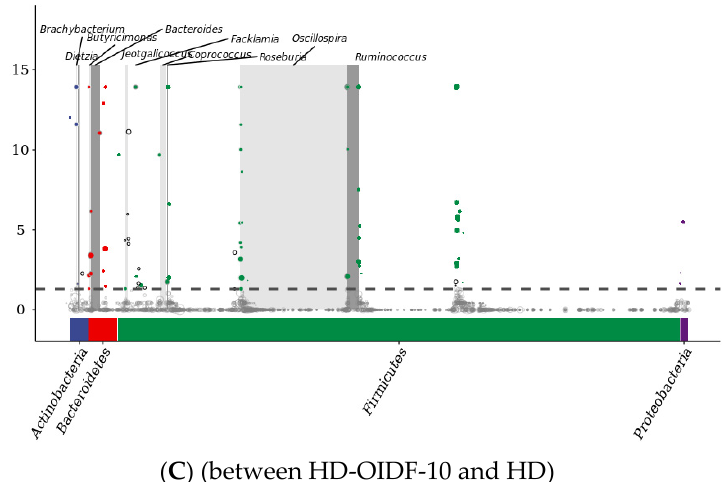
Figure 8. Species differences and marker analysis: ( A ) Species composition heatmap; ( B ): PCA analysis; ( C ): MetagenomeSeq analysis. (G: HD group; K: NC group; S: HD-OIDF-10 group; M: HD-OIDF-50 group; L: HD-OIDF-100 group).